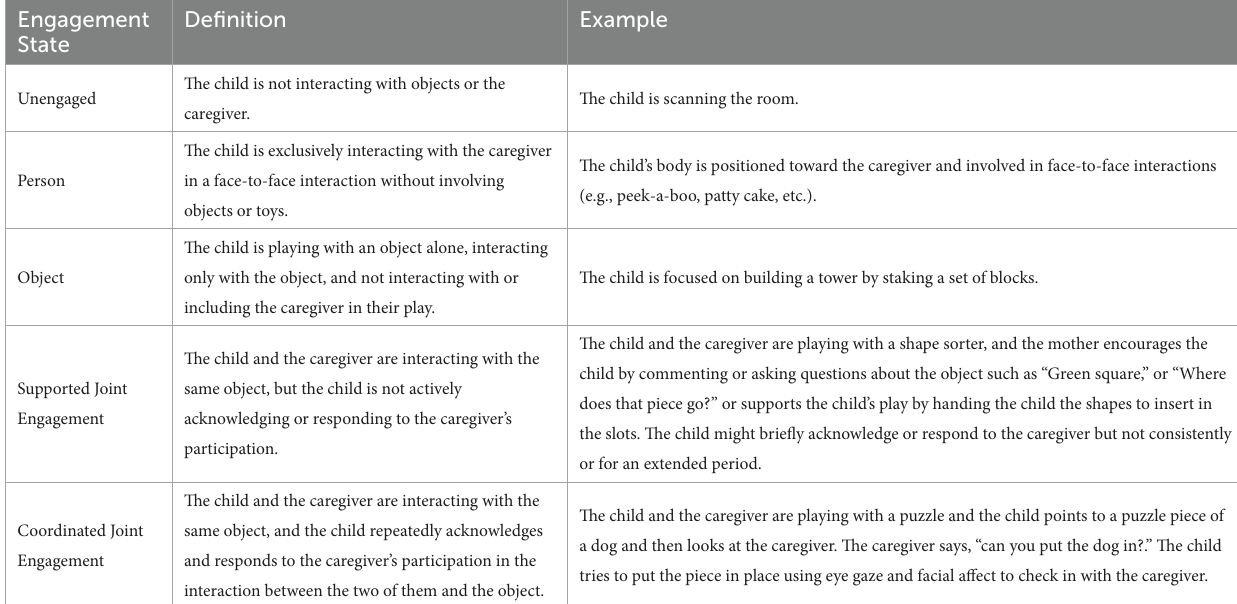
TABLE 1 Definitions and examples of engagement